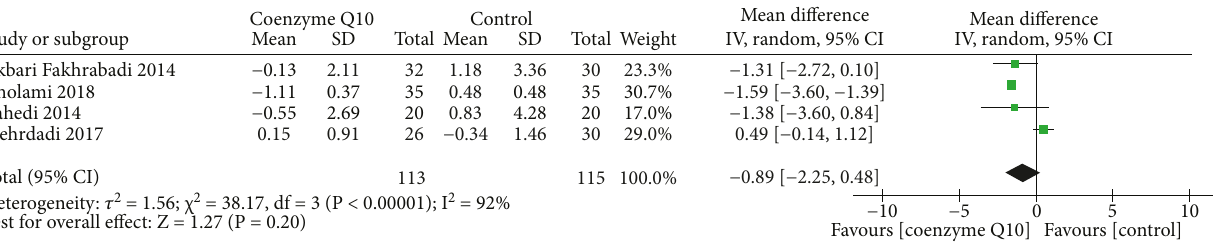
Figure 6: Homeostasis model assessment of insulin